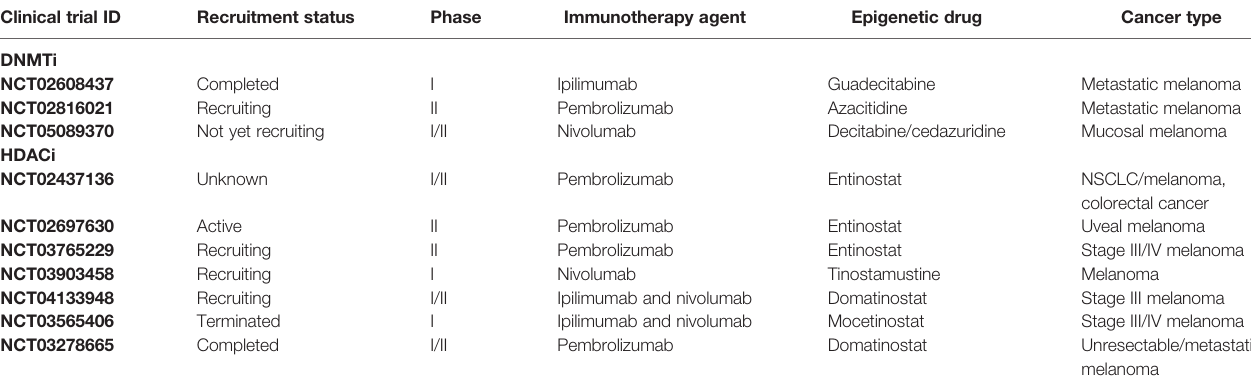
TABLE 2 | List of clinical trials combining epigenetic drugs and immunotherapy in